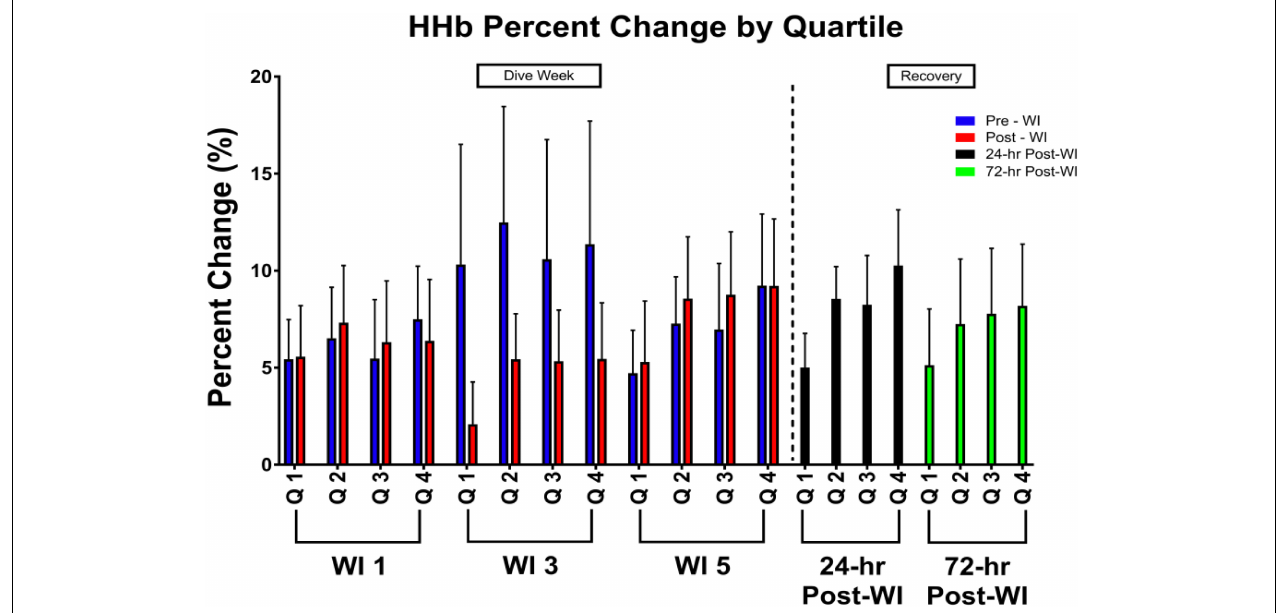
FIGURE 4 | Forty percent MHE HHb percent change by quartile results. Across subject ( n = 13) mean ± SEM is shown. Each WI quartile was compared to its baseline counterpart. For example, WI 3 Q1 compared to WI 1 Q1; WI 3 Q2 compared to WI 1 Q2; WI 5 Q1 compared to WI 1 Q1; WI 5 Q2 compared to WI 1 Q2. No significance was